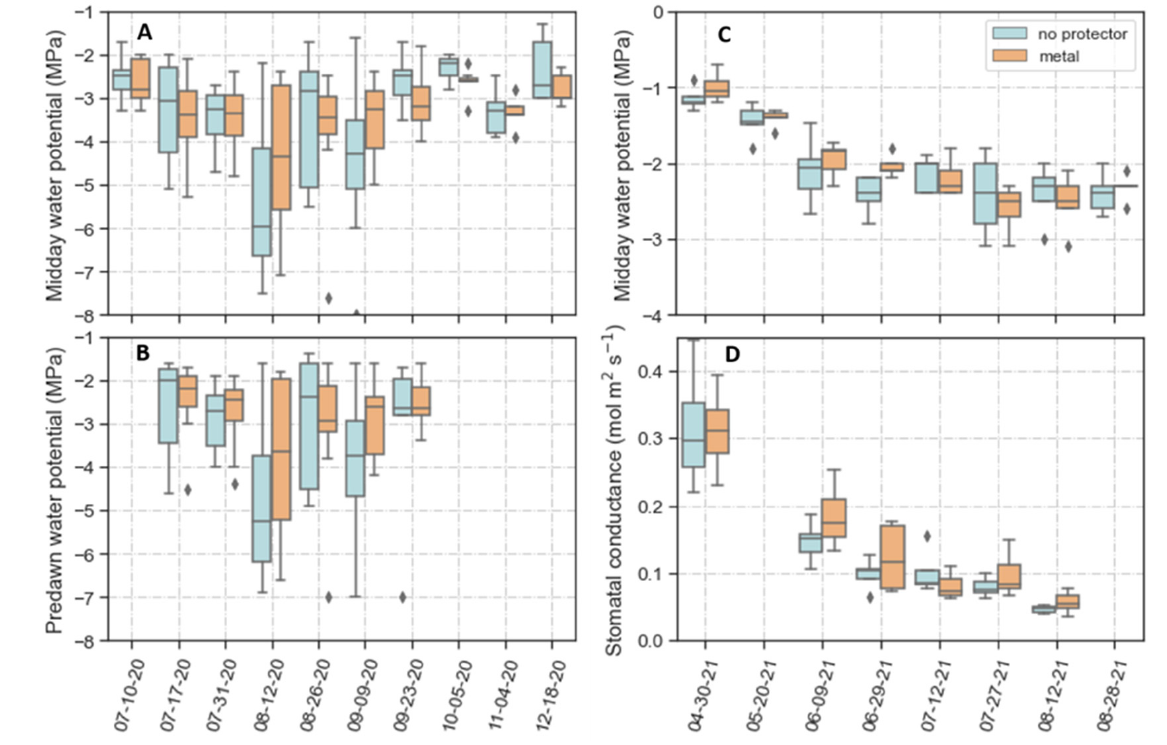
Figure 5. Plant water status of Artemisia tridentata seedlings without protectors and within metal protectors during the summer and fall of 2020 ( A , B ) and the spring and summer of 2021 ( C , D ). Seedlings were outplanted in October 2019. ( A ) Midday water potential. ( B ) Predawn water potential. ( C ) Midday water potential. ( D ) Stomatal conductance. Diamonds indicate outliers. Note: The days when water potentials were measured are plotted as categorical variables rather than a continuous time sequence to make the boxplots more noticeable.